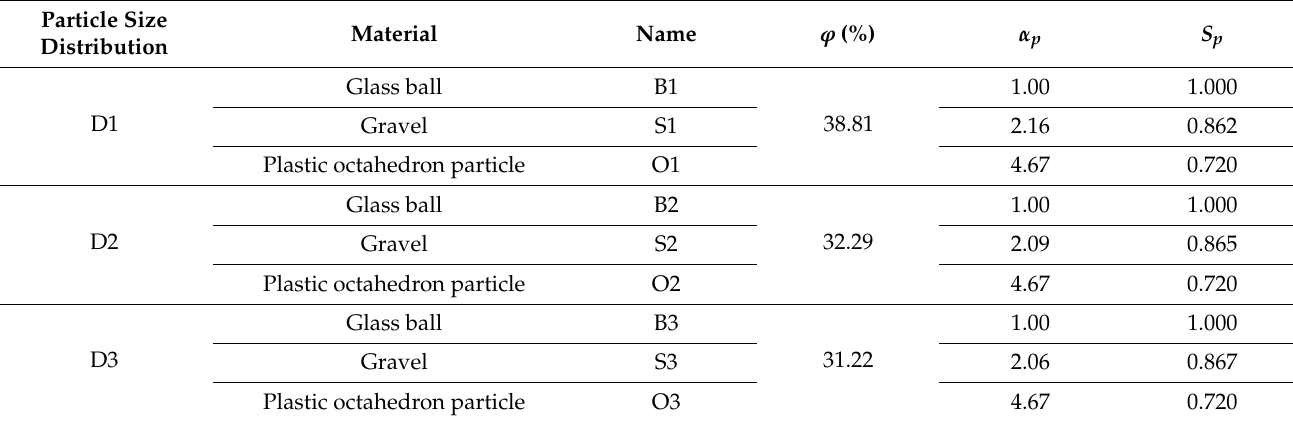
Table 3. Parameters of the